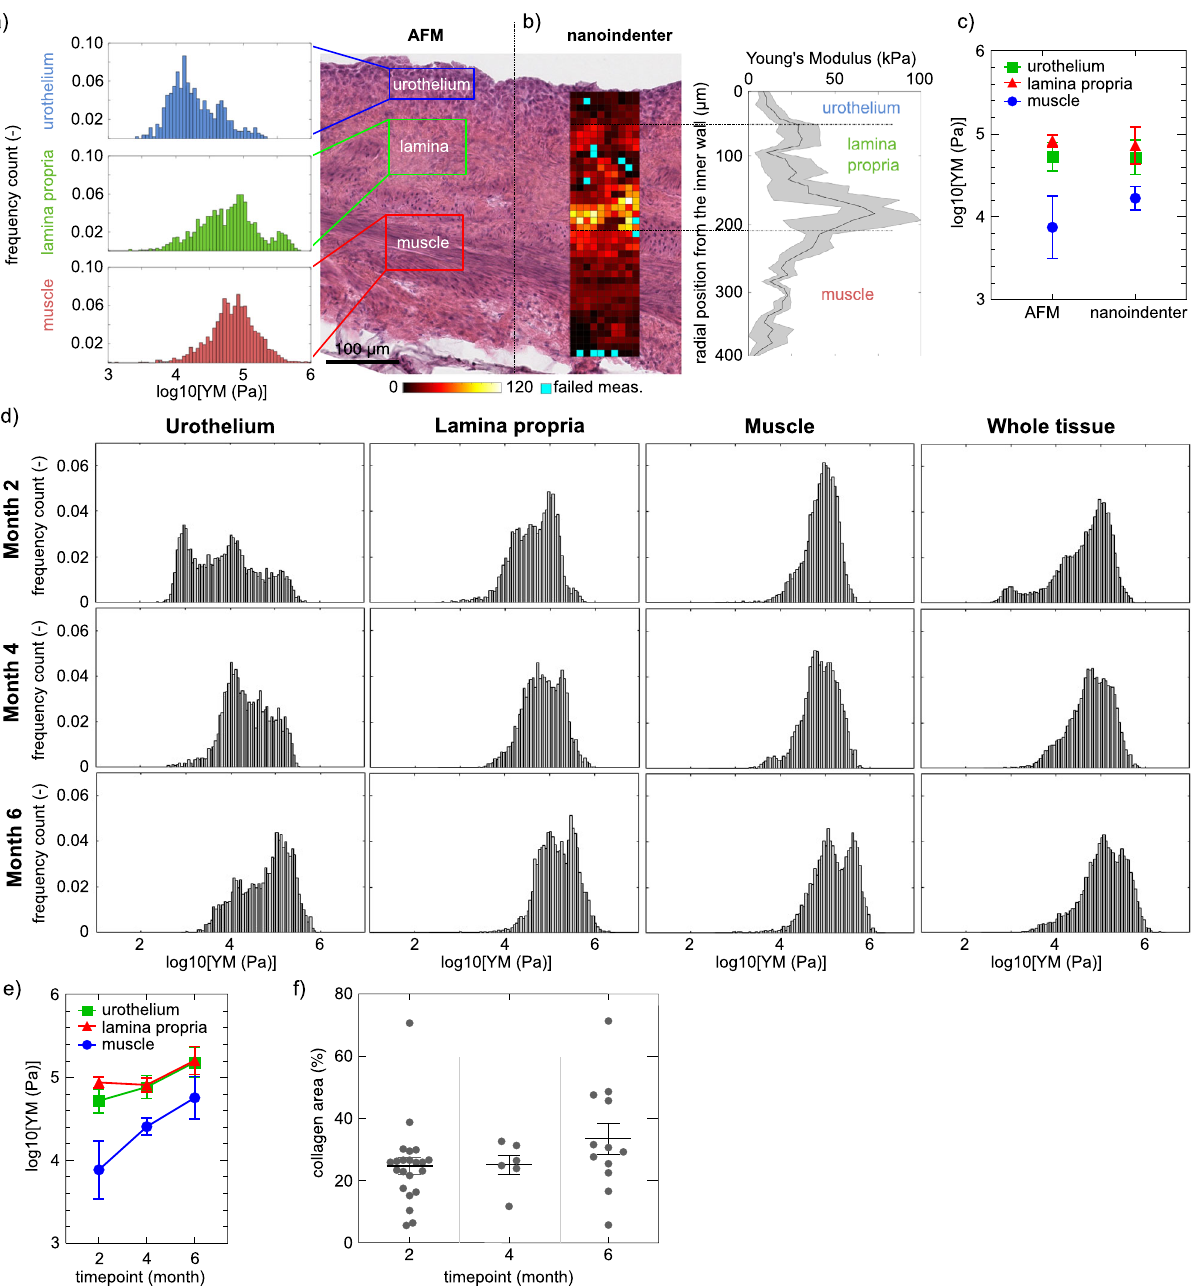
Fig. 1 Micromechanical map of healthy bladder wall and aging effect on stiffness. a YM by AFM represented in logarithm in base 10 (log10) in Pa for the different bladder tissue layers. b YM values obtained with the nanoindenter. The mechanical heterogeneity of the bladder correlates with its anatomical distribution: there is a gradient of YMs, being the urothelium the softest layer, with increasing stiffness when reaching the lamina propria, and then decreasing over the muscle layers. The association of stiffness gradients with the anatomical bladder tissue layers is shown by overlay of the mechanical map with hematoxylin-eosin staining. Blue pixels indicate rejected measurements. c Mean of the median values of a healthy rat bladder wall ± SEM, extracted by the two instruments. AFM and nanoindenter provide comparable results (2-way Anova test showed no statistically signi fi cant differences). For a complete comparison of between nanoindenter and AFM, the reader is referred to the Supplementary Fig. 4. d Evolution of the stiffness of the different bladder tissue layers (urothelium, lamina propria and muscle) with aging of the adult animal (AFM and nanoindenter data pulled together). The distribution of YM values for the whole tissue (i.e. all layers together) is also shown. N = 3 rats per time point, each tissue layer of each single rat is characterized by over 3000 force curve measurements. Data shown are logarithm in base 10 of YM ’ s (in Pa). e Mean of the median values of each rat ± SEM. Nonparametric Mann-Whitney test showed no statistical signi fi cant differences when comparing the different tissue layers at the studied time points. f Quanti fi cation of the bladder area that expresses collagen from control rats at different time points; each symbol represents the measurement in a tissue slice, with multiple slices measured for each bladder, in three animals. Source data behind graphs and charts can be found in https:// fi gshare.com/ projects/Micro-mechanical_ fi ngerprints_of_the_rat_bladder_change_in_actinic_cystitis_and_tumor_presence/158222.